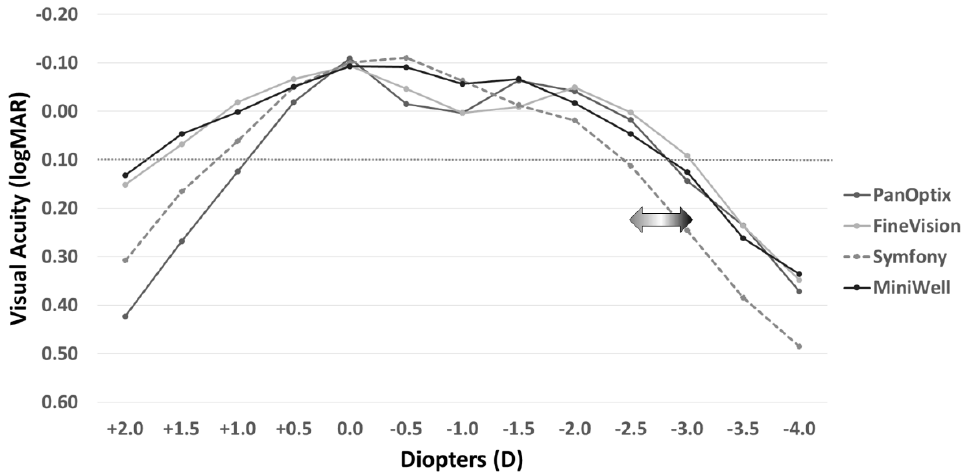
Figure 2. Distant-corrected binocular defocus curves with PanOptix, FineVision, Symfony, and MiniWell. PanOptix, FineVision, and MiniWell maintained visual acuity above 0.10 logMAR at the defocus power of − 2.5 D, whereas Symfony presented with narrower depth of focus than the other IOLs. Symfony and MiniWell provided better visual acuity at the defocus power of −0 .5 D and −1 .0 D, and MiniWell presented with more extended defocus curve than Symfony. Table 2. Refractive outcome and predictive error in the four IOL groups.